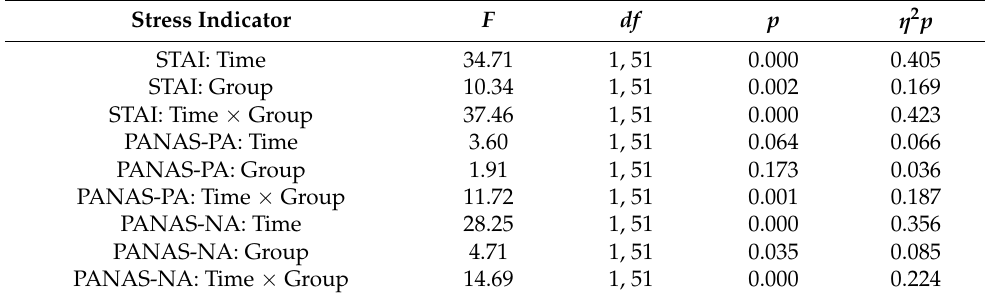
Table 1. Manipulation check for stress